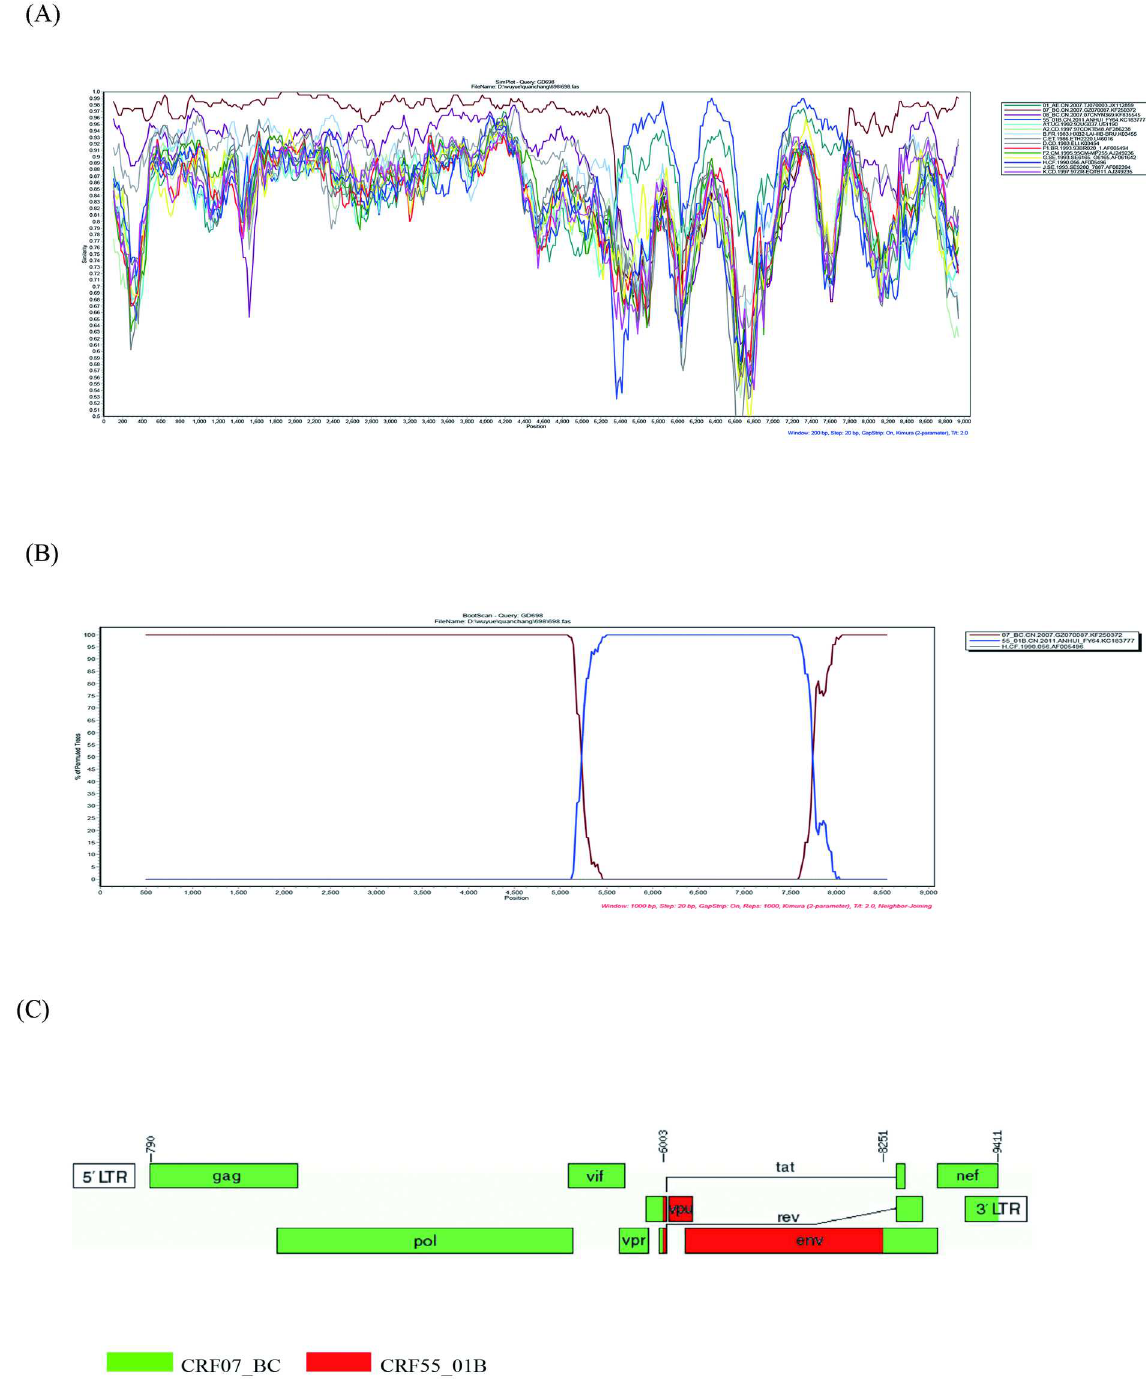
Fig 2. Characterization of GD698 isolate. (A) The similarity betweenGD698 and the reference sequenceswas plotted using SimPlot 3.5.1 software. (B) Bootscanning analysesof the NFLG of GD698. CRF55_01B (KC183777)and CRF07_BC (KF250372) were used as putative parental reference sequences,and subtype H (AF005496)was used as an outgroup.(C) Recombinant map results for GD698. The schematic structure was created using the RecombinantHIV-1 DrawingTool (www.hiv.lanl.gov/content/ sequence/DRAW_CRF/recom_mapper.html). Break point positionsrelative to HXB2 numberingwere located by the HIV Sequence Locator (www.hiv.lanl.gov/content/sequence/LOCATE/locate.html).